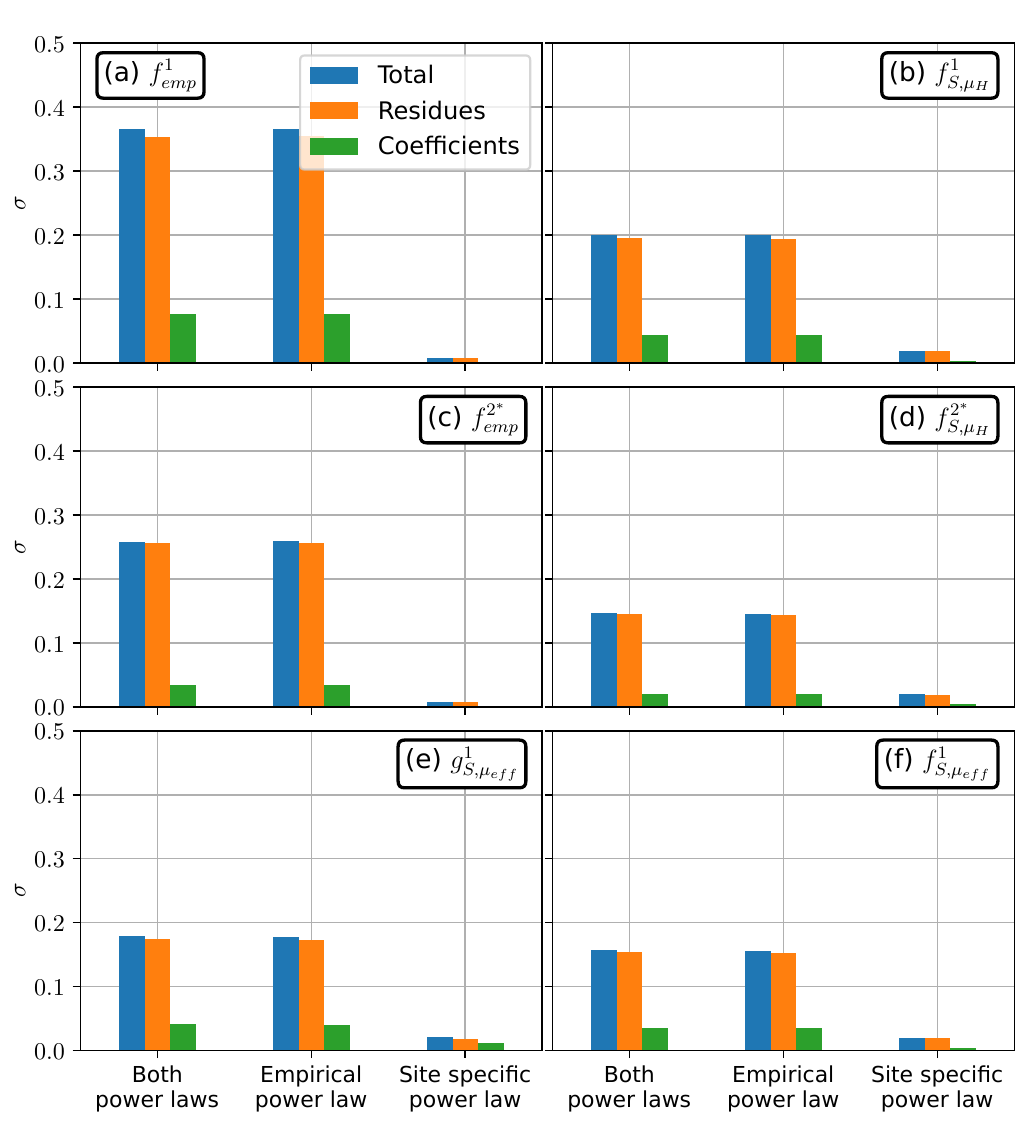
Figure A6. Uncertainty in travel distance estimation for the Fei Tsui Road cliff case study, and a variation of DB2 with only debris flows, debris avalanches and debris slides. The corresponding travel distance estimations are marked with the super-script 2 ∗ . Notations are otherwise the same as in the main body of the article. ( a – f ), and symbology are the same as for Figure